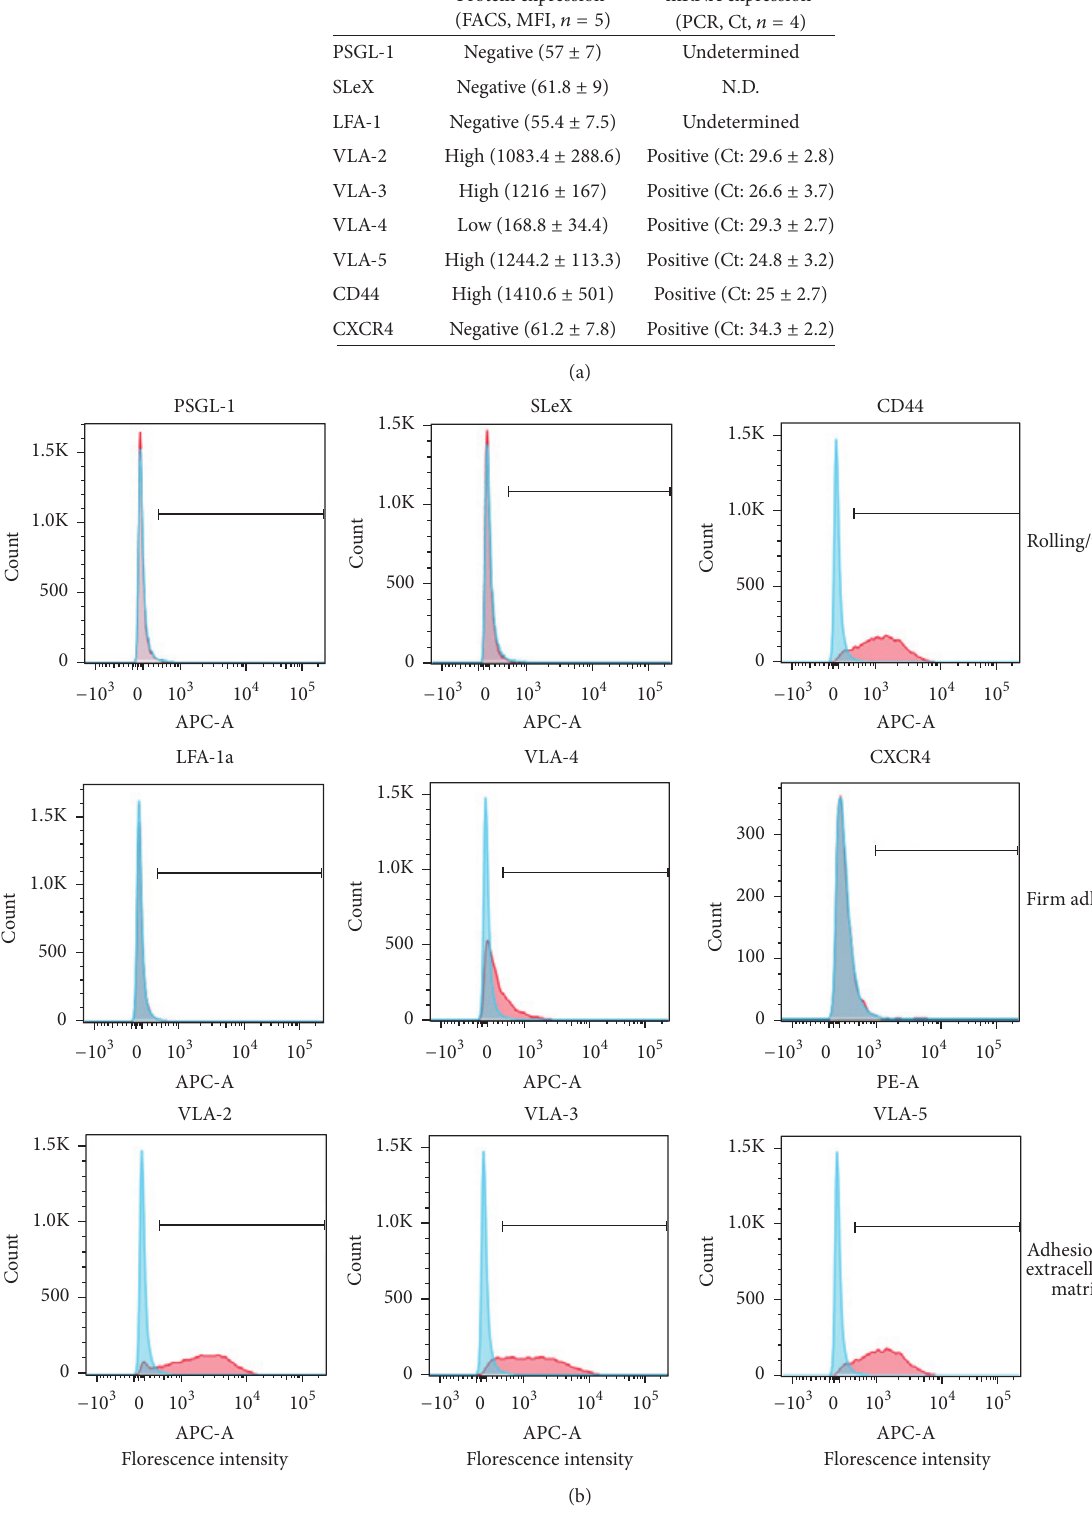
Figure 2: Antigen and mRNA expression of the main molecules involved in the engraftment process. (a) Results are expressed in mean ( ± standard error of the mean) of median fluorescence intensity for the protein expression (FACS; 𝑛 = 5 donors) and of Ct values for the mRNA expression (real-time PCR; 𝑛 = 4 donors). (b) Histograms of the antigens PSGL-1, LFA-1 𝛼 , VLA-4, and VLA-5; analyses with FlowJo. Red histograms represent cells stained for the antigen of interest versus cells stained with appropriate isotype controls in